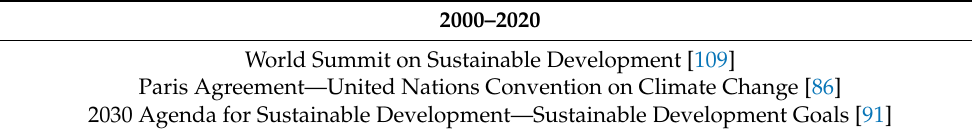
Table 9. Events carried out by the